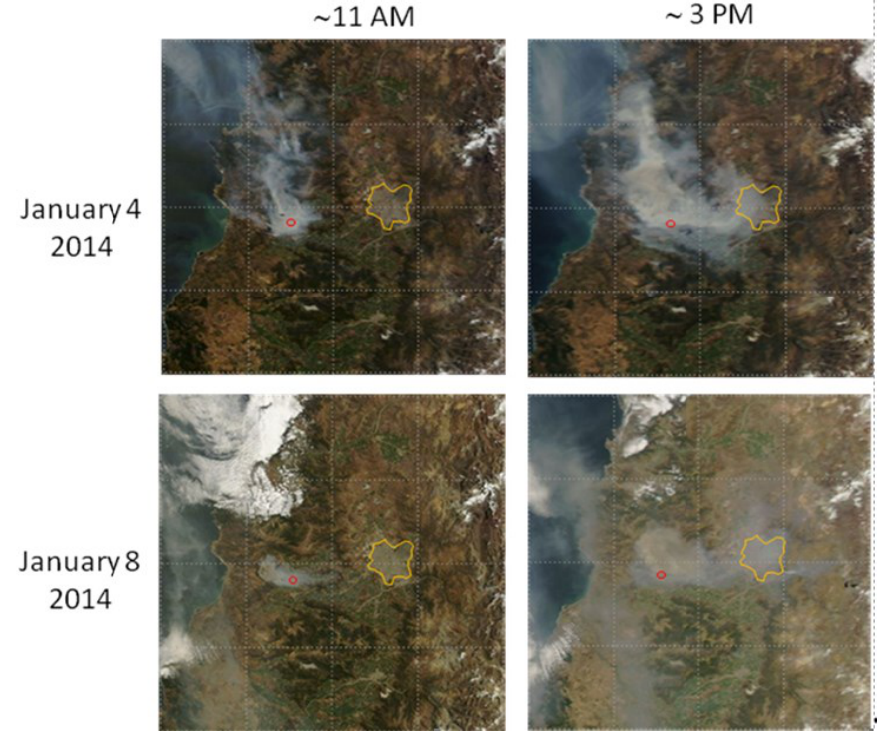
Figure 2. Corrected reflectance (True Color) scenes from MODIS for 4 and 8 January 2014, over central Chile (same region as in Figure 1). The plume of the forest fires in the Melipilla sector (red circle) reaching Santiago (yellow polygon) is evident in all the images. The left column shows images from the AQUA satellite at about 11 a.m., the right column shows images from the TERRA satellite at about 3 p.m.